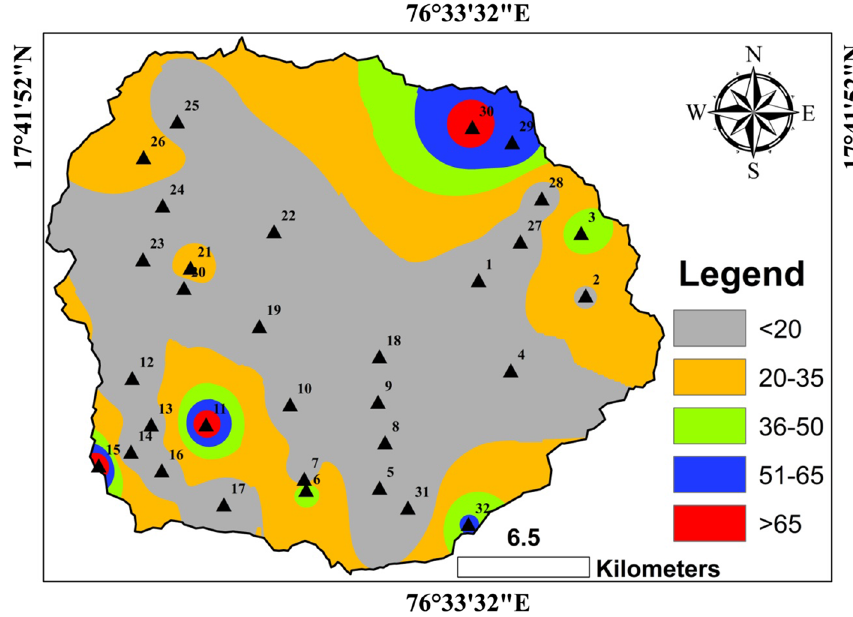
Fig. 26 Geospatial distribution of nitrate (pre-monsoon)